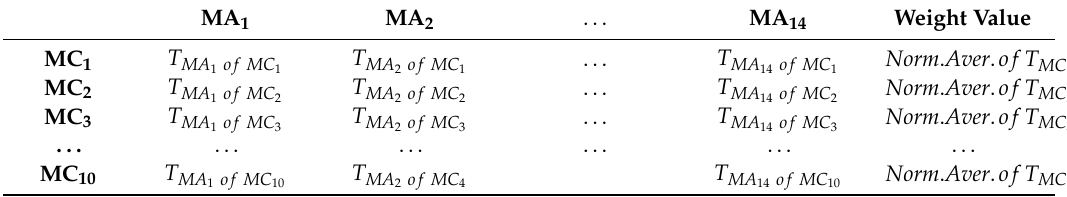
Table 3. MA training transition matrices and weight values for each